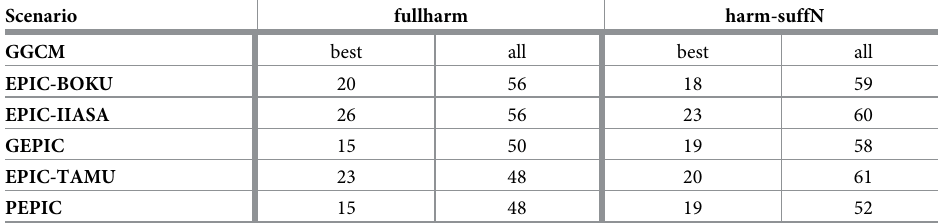
Table 4. Numbers of countries (out of 99 for which benchmark data and GGCM outputs are available) in each harmonized setup scenario, in which each EPIC-based GGCMs has the highest (column “best”) performance com- pared against reported yields within the EPIC ensemble and all countries (column “all”) in which the correlation coefficient is significant at p < 0.1 and positive. Scenario fullharm harm-suffN GGCM best all best all